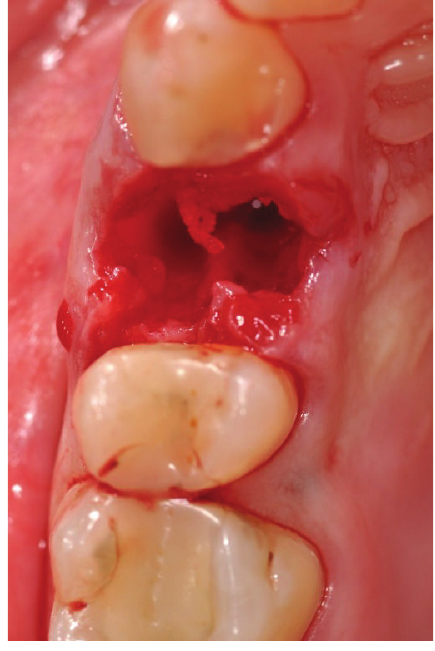
Figure 4: Upper right first premolar area after the extraction of the